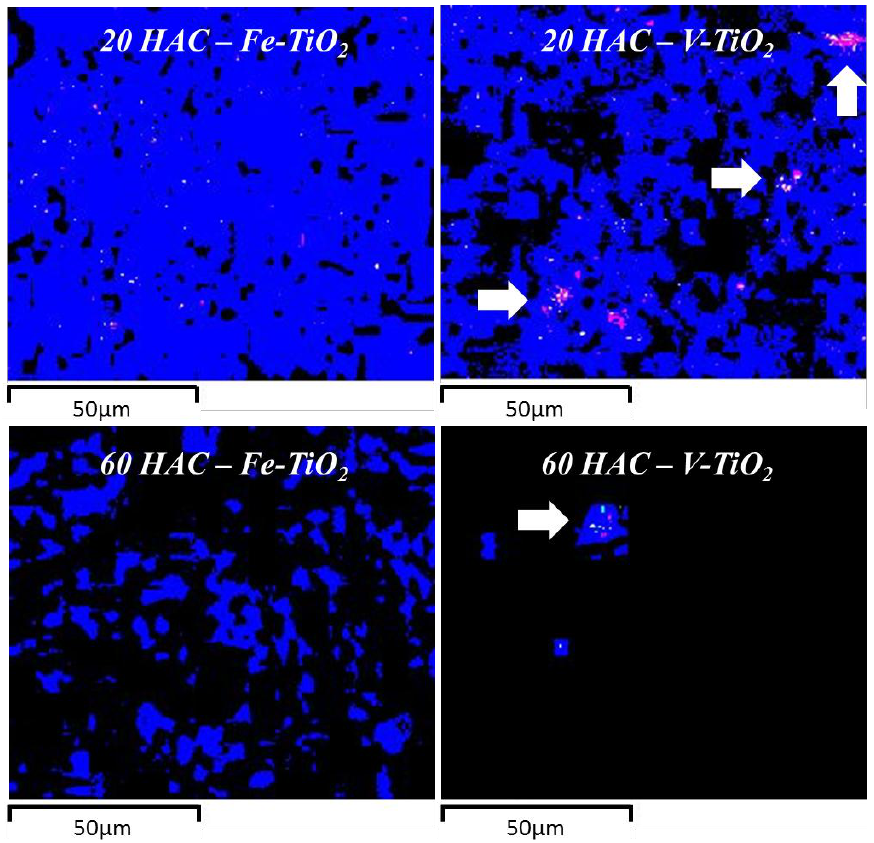
Figure 12. Comparative Ti distribution (SEM-EDS) of HAC mortars (after 28 curing days) with Fe-TiO 2 and V-TiO 2 nanostructured additives (included in 2.5 wt. %). For the purpose of clarity, due to the low ratio of Ti in the mortars, images were equally adjusted (brightness and contrast). Areas showing an accumulation of Ti in the V-TiO 2 samples are indicated with arrows.